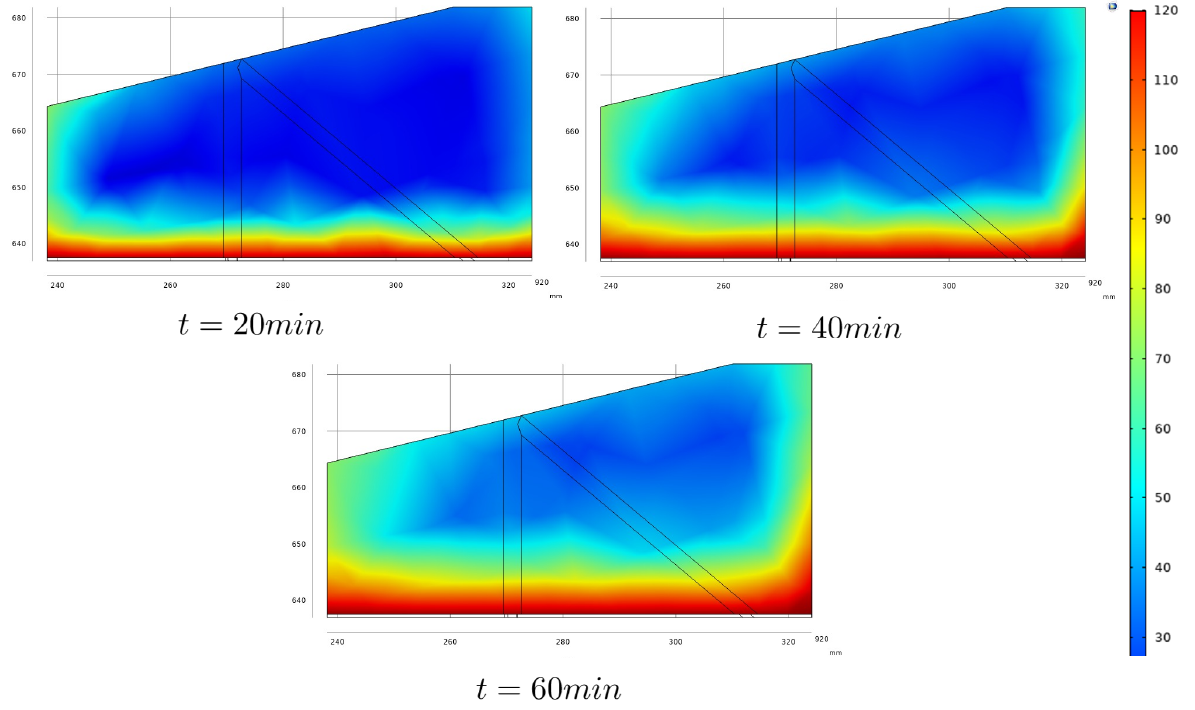
Figure 5. Simulated frames showing the temperature distribution in a longitudinal section taken in the center of the wedge for three specific times. They will be used as temperature distribution maps in the high-temperature ultrasonic NDT simulation presented in Section